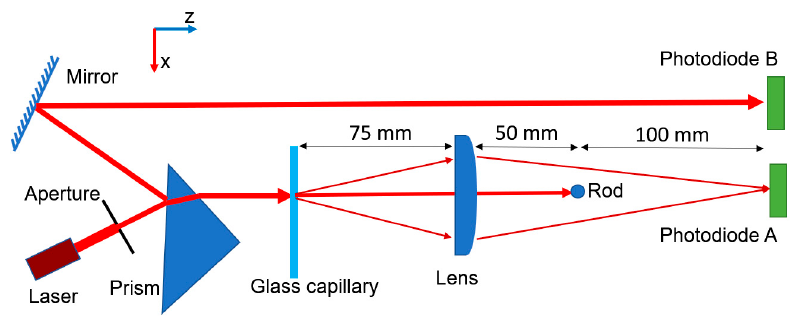
Figure 1. The schematic of nephelometric system. Red arrows indicate light path.